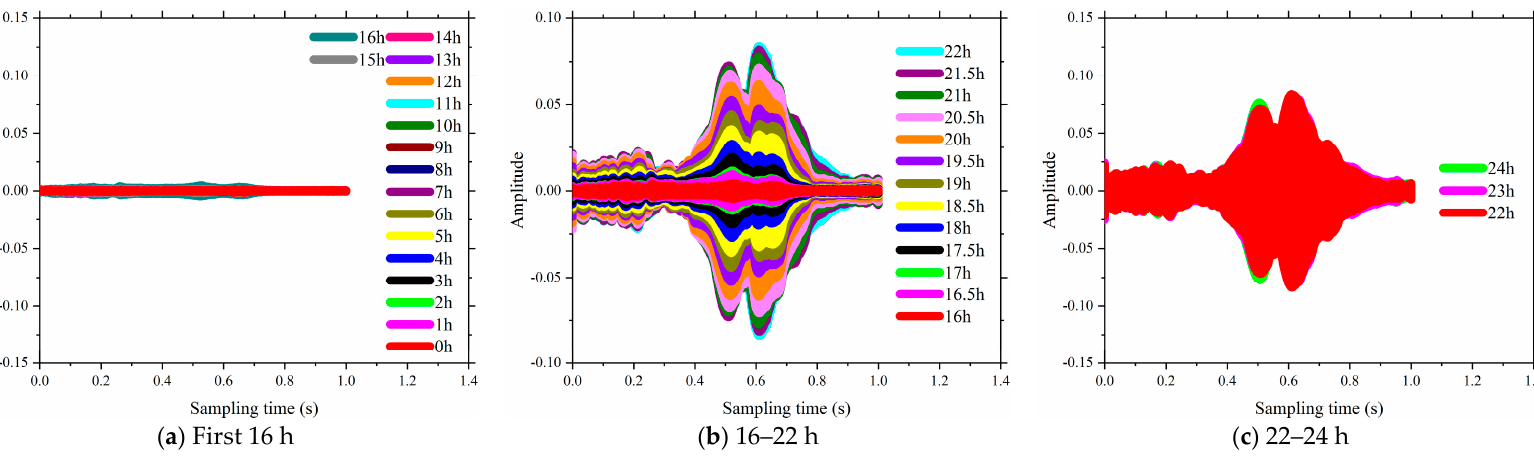
Figure 16. Influence of volume of fly ash on the signal amplitude at hydration monitoring (FA-60%).